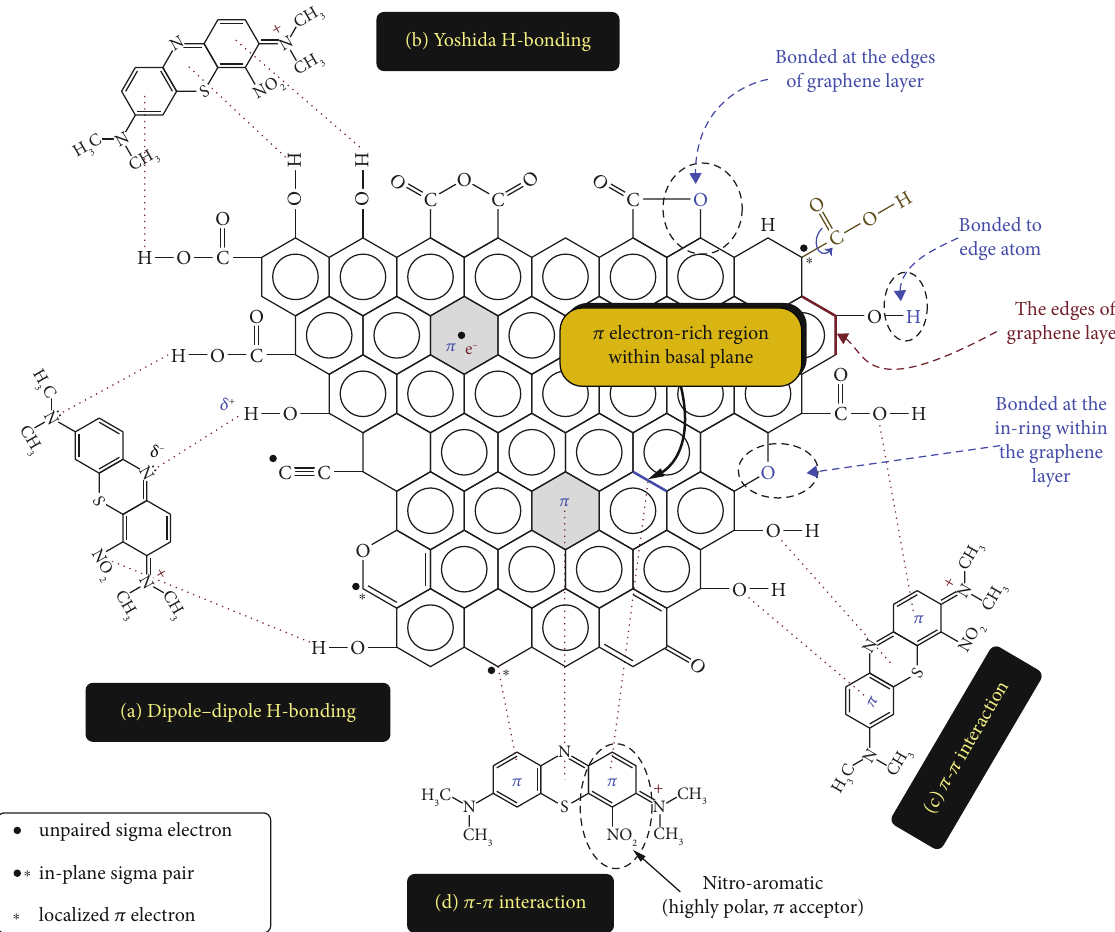
Figure 3: Possible interactions between various pollutants and activated